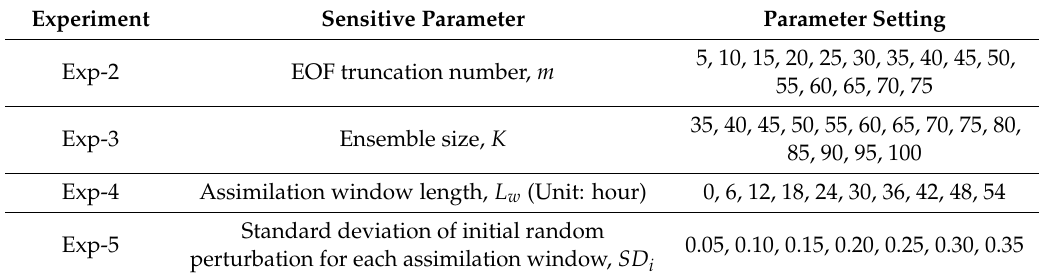
Table 1. Settings of sensitivity experiments for parameters related to the EOF analysis in the DRP-4DVar.